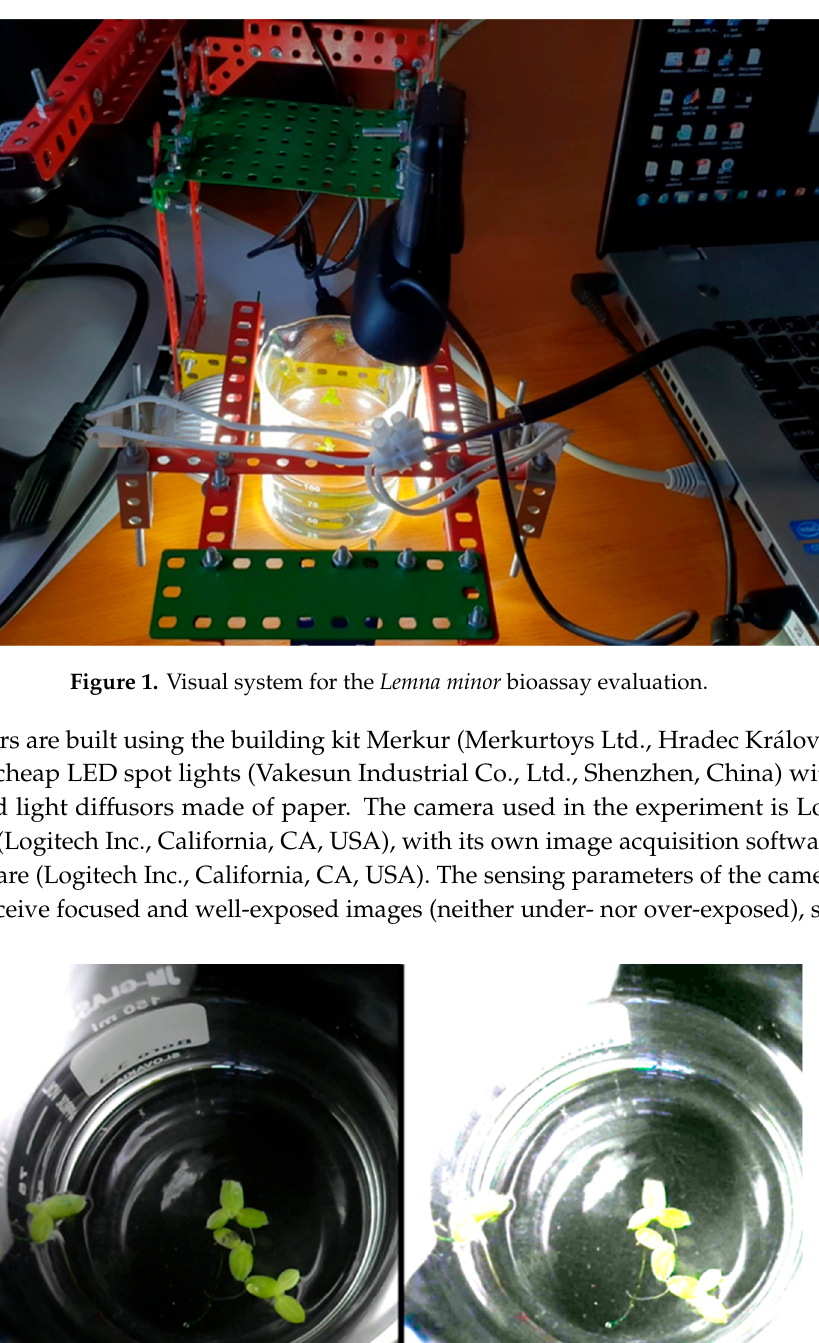
Figure 2 Well exposed ( left ) and overexposed ( right ) images.